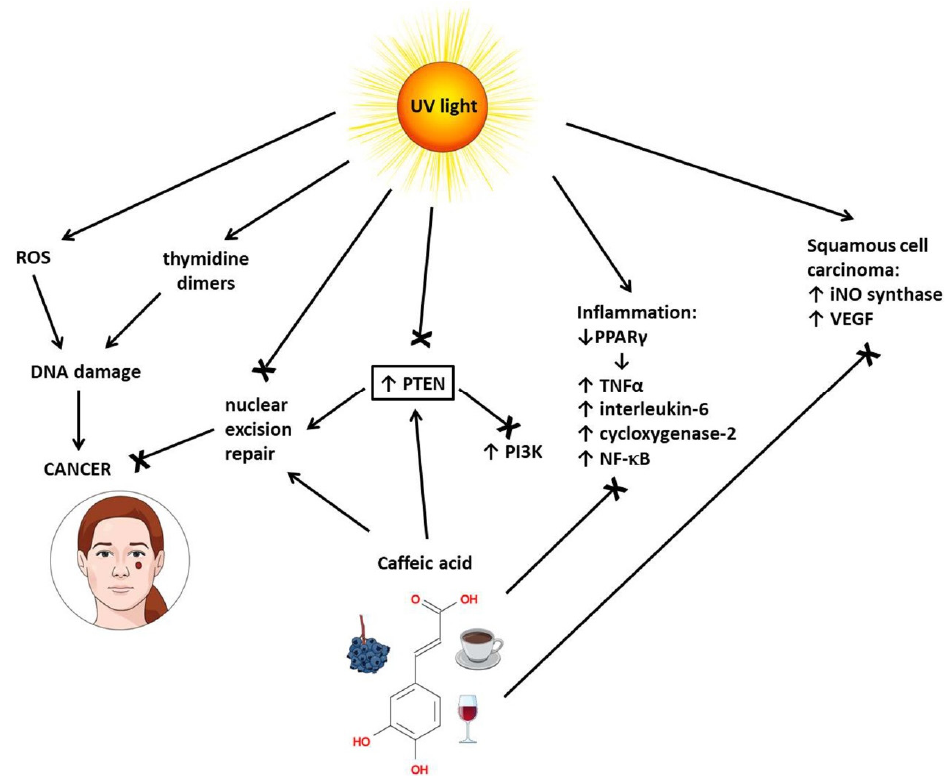
Figure 2. Protective effect of caffeic acid against skin cancer. ROS means reactive oxygen species, PTEN means phosphatase and tensin homolog, PI3K means phosphoinositide 3-kinase, PPAR γ means peroxisome proliferator-activated receptor gamma, TNF α means tumor necrosis factor alpha, NF- κ B means nuclear factor kappa B, iNO synthase means inducible nitric oxide synthase, and VEGF means vascular endothelial growth factor.